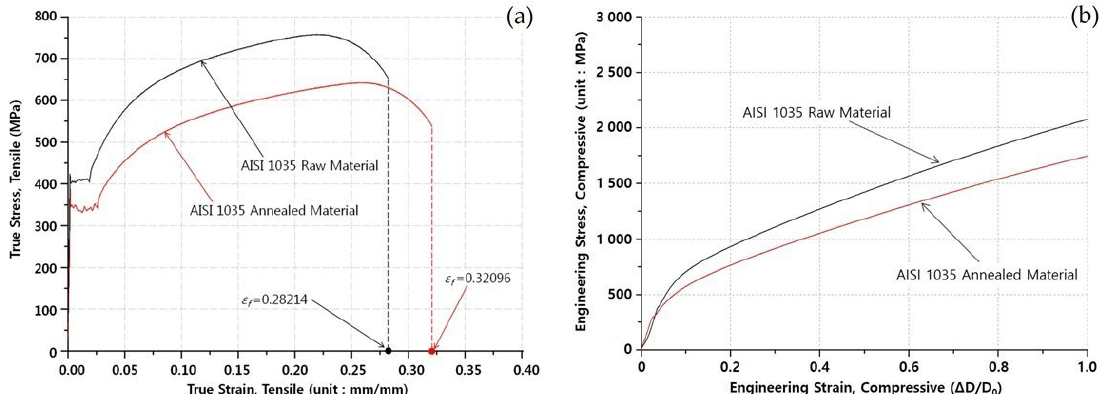
Figure 3. Stress-strain curves of AISI 1035 medium carbon steel as a cold drawn round workpiece before and after spheroidizing annealing: ( a ) Tensile stress-strain curves; ( b ) Compressive stress-strain curves. Table 2. Mechanical properties of AISI 1035 medium carbon steel as a cold drawn round specimen.